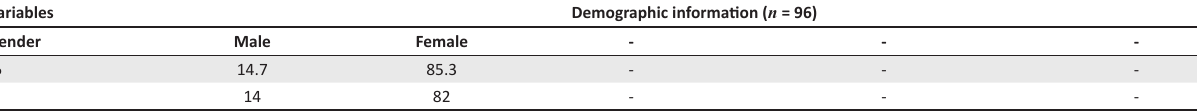
TABLE 1f: Summary of the demographic information of the participants. Variables